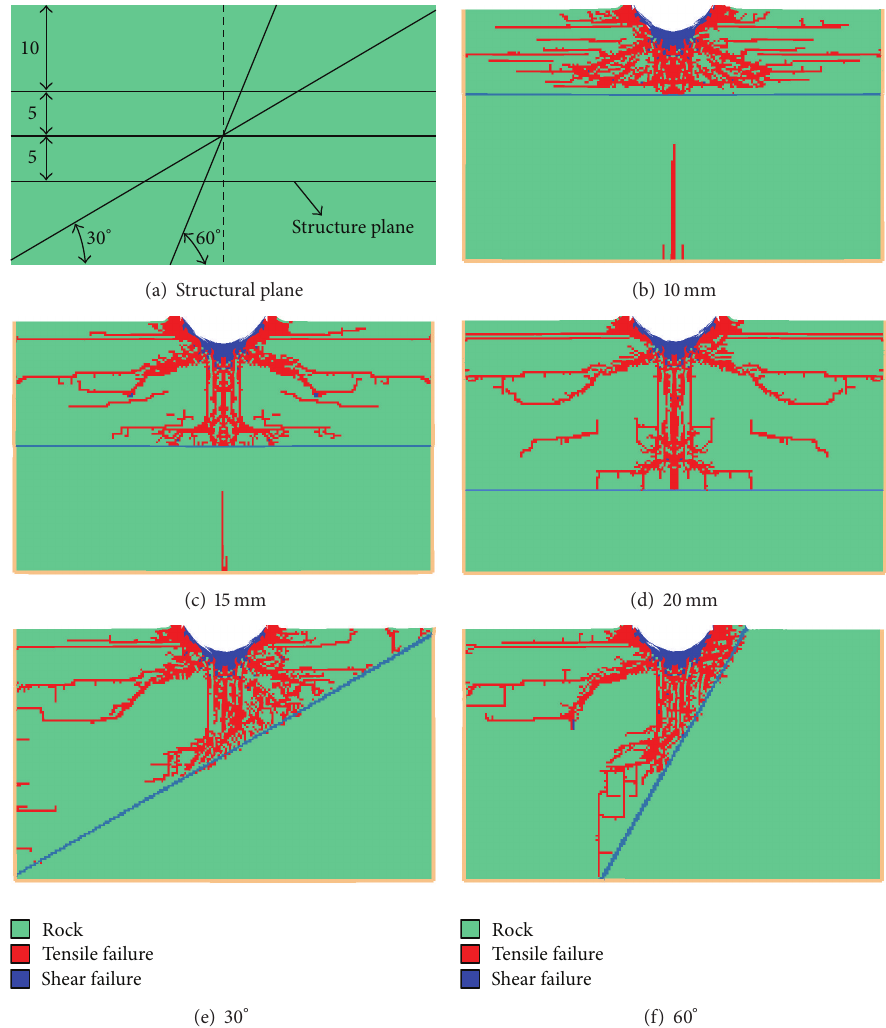
Figure 13: Rock fragmentation with different structure